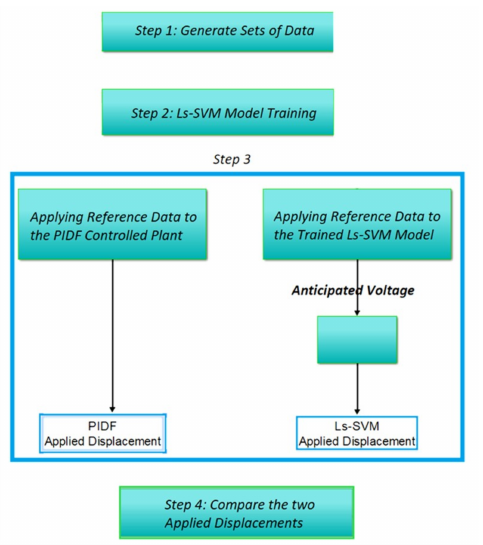
Figure 5. Flowchart of the performance assessment of the LS-SVM feed-forward controller.